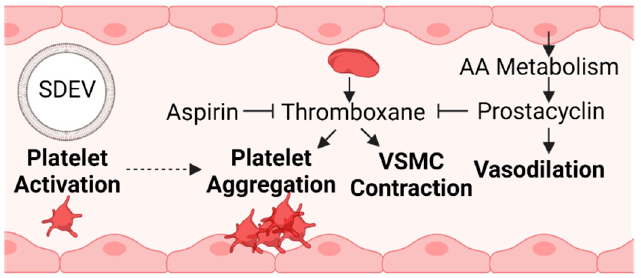
Figure 4. An imbalance in coagulation factors promotes a more prothrombotic environment during preeclampsia [226–228]. Prostacyclin is a vasodilatory product of arachidonic acid metabolism derived from endothelial cells [225]. Prostacyclin and aspirin oppose the actions of thromboxane, and the ratio of prostacyclin to thromboxane decreases in preeclampsia [226,229]. The accumulation of placental stress can lead to the release of SDEVs into maternal circulation. SDEVs can promote platelet activation, a precursory step to platelet aggregation and the formation of blood clots [29,230] (SDEV, syncytiotrophoblast-derived extracellular vesicle; VSMC, vascular smooth muscle cell; AA, arachidonic acid).